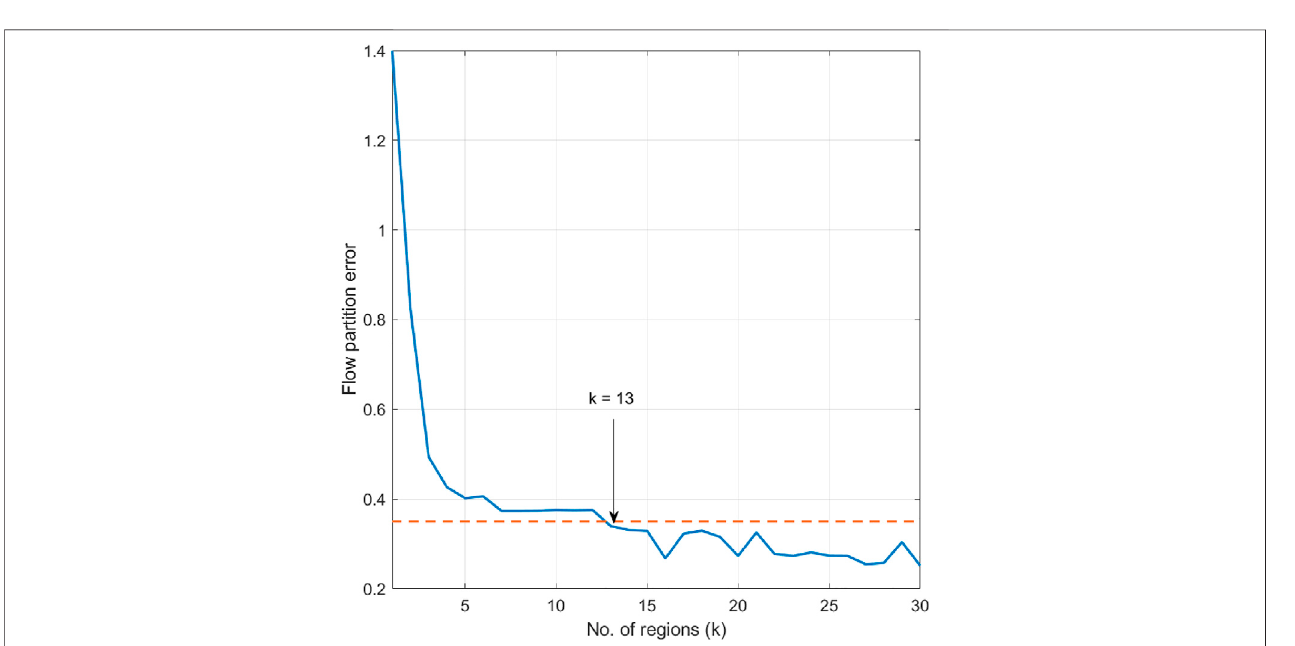
FIGURE 4 | Flow partition error when the number of cells is set as k (cid:2) 1 , ... , 30.